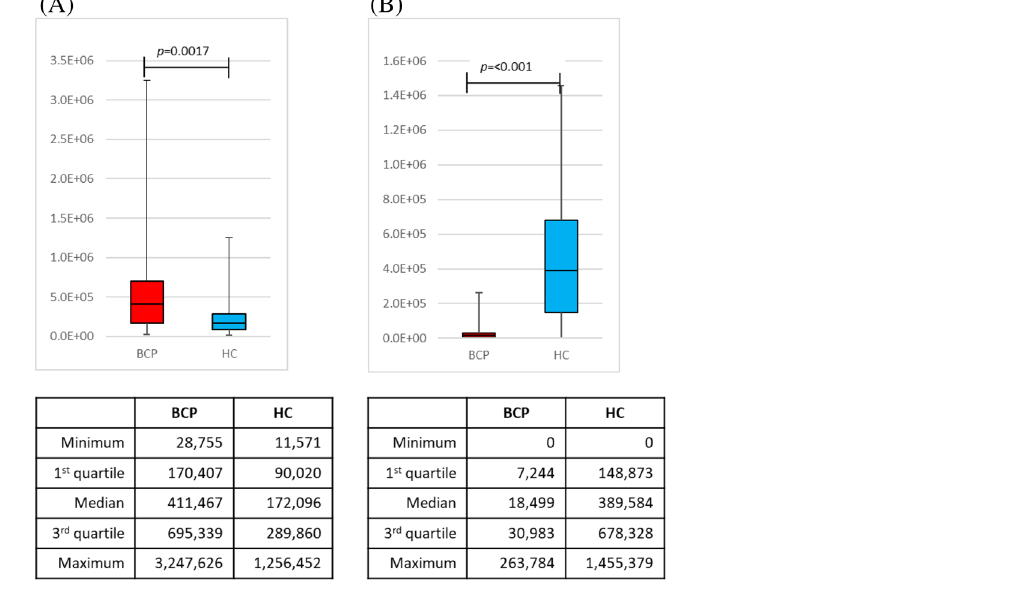
Figure 2. Box charts of the peak areas of the 2-butanone and 2-propanol using the model. Box plots of the peak areas of 2-propanol and 2-butanone generated by the model. The model indicated that 2-butanone was higher in breast cancer patients than in healthy controls ( A ), and that 2-propanol was higher in healthy controls than in breast cancer patients ( B ). BCP breast cancer patient, HC healthy